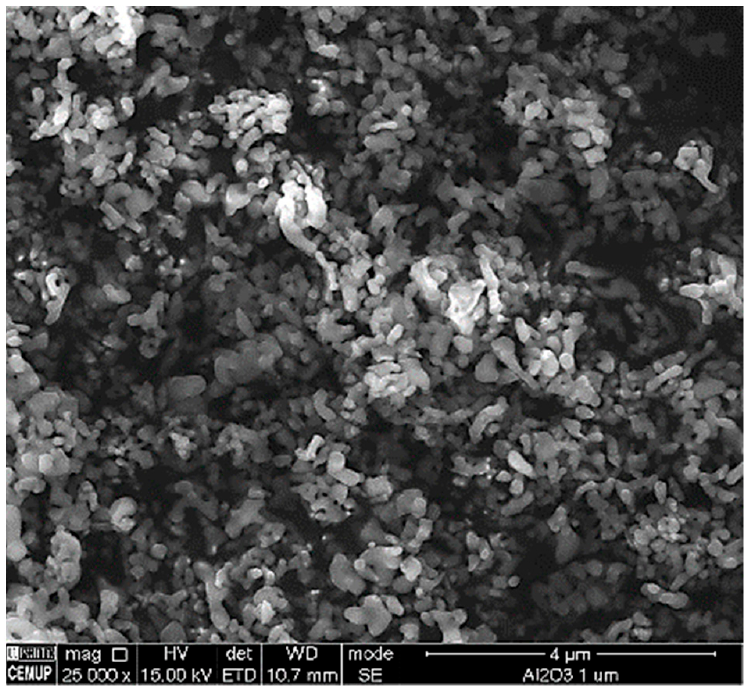
Figure 1. Morphological characterization of the abrasive particles: Alumina Powder-Deagglomerated Alpha 3 μ m.